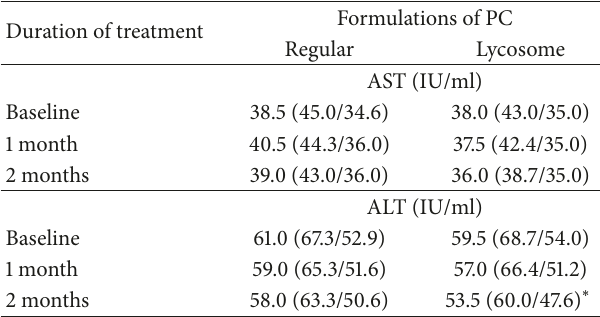
Table 3: Serum AST/ALT activity after treatment with regular and lycosome formulations of PC (medians with 95/5%%